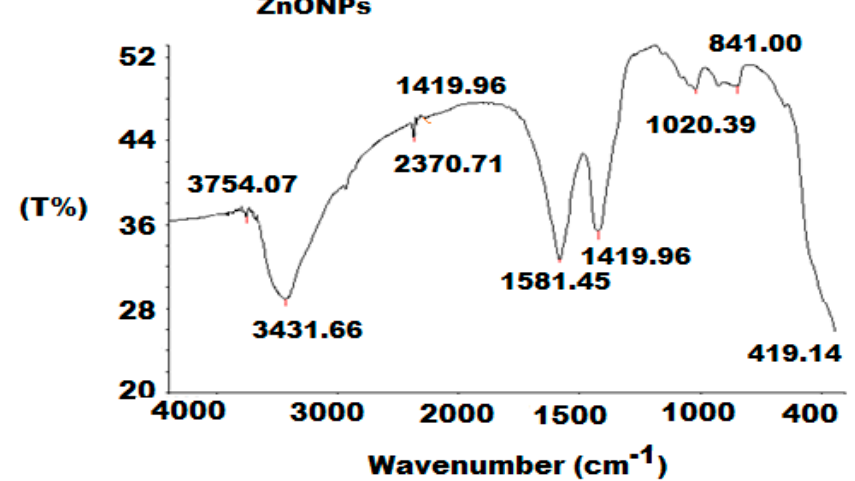
Figure 4. Fourier-Transform Infrared spectroscopy (FT-IR) spectrum of zinc oxide nanoparticles (ZnONPs) at a wavenumber from 4000 to 400 cm − 1 .